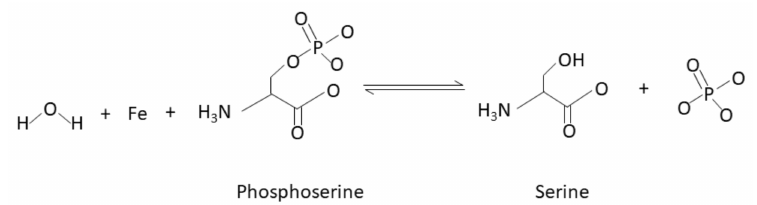
Figure 3. Chemical equation of dephosphorylation of a serine residue by an iron atom located in the CaN-active site adapted from Kissinger et al. (1995). A water molecule is deprotonated by the iron atom, followed by a hydrolysis reaction between the deprotonated (activated) water molecule and phosphorylated serine residue (phosphoserine). This reaction yields serine and phosphate. Threonine substrates follow a similar mechanism of water activation and dephosphorylation